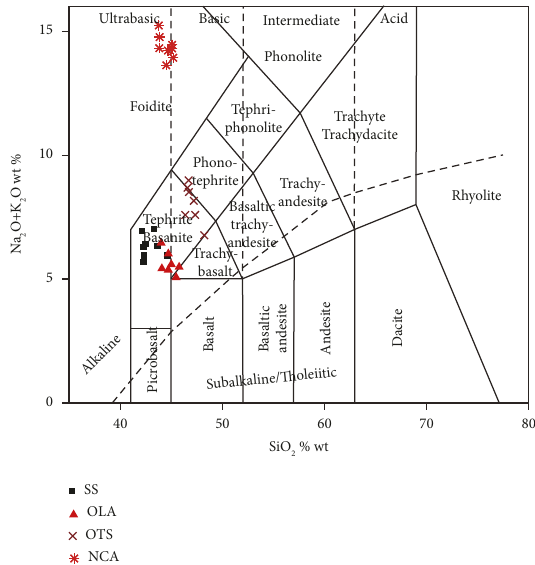
Figure 11: TAS classification diagram [33] of SS, OTS, OLA, and NCA samples plotted using GCDkit software